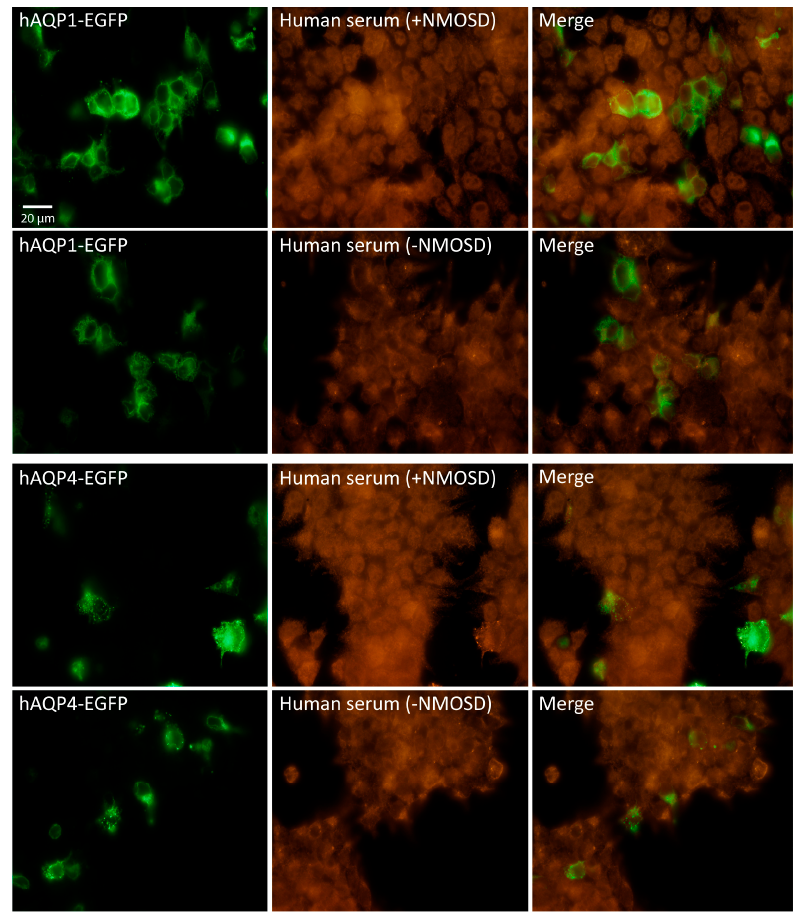
Figure 2. Immunofluorescence assay in HEK cells treated with Triton X-100. Panels are as indicated in Figure 1, but here experiments were done using a protocol of permeabilization with triton X-100 as indicated in the text (material and methods section). High background of fluorescent signal (middle column panels) was detected over all cells in the plate regardless expression or not of AQPs in them, confirming unspecific reaction. Scale bar = 20 µm